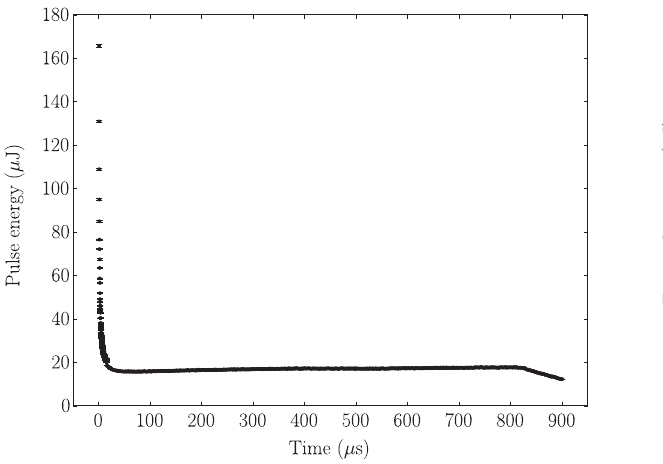
FIG. 5. Amplified pulse energies for a seed delay of 200 μ s relative to the pump.